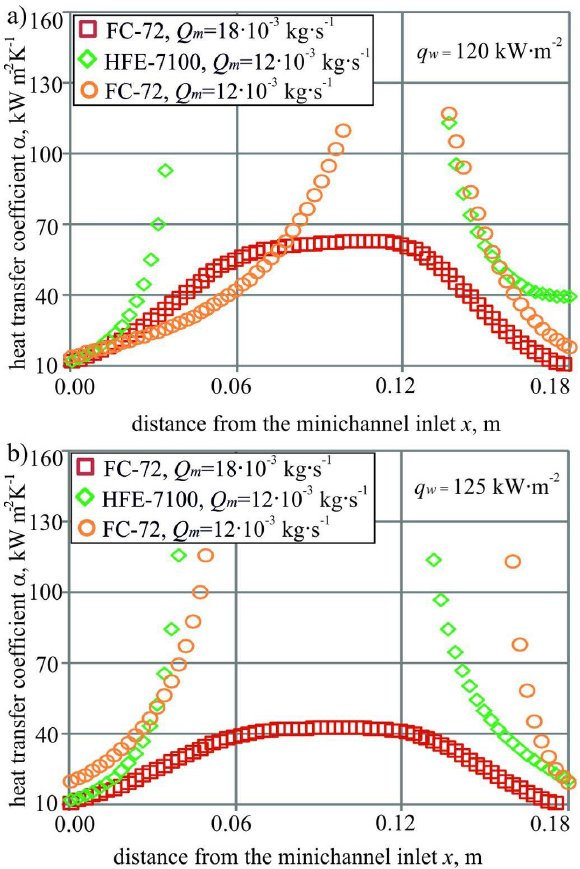
Fig. 7. Heat transfer coefficient vs. distance from the minichannel length obtained for the saturated boiling region, experimental parameters shown in Table